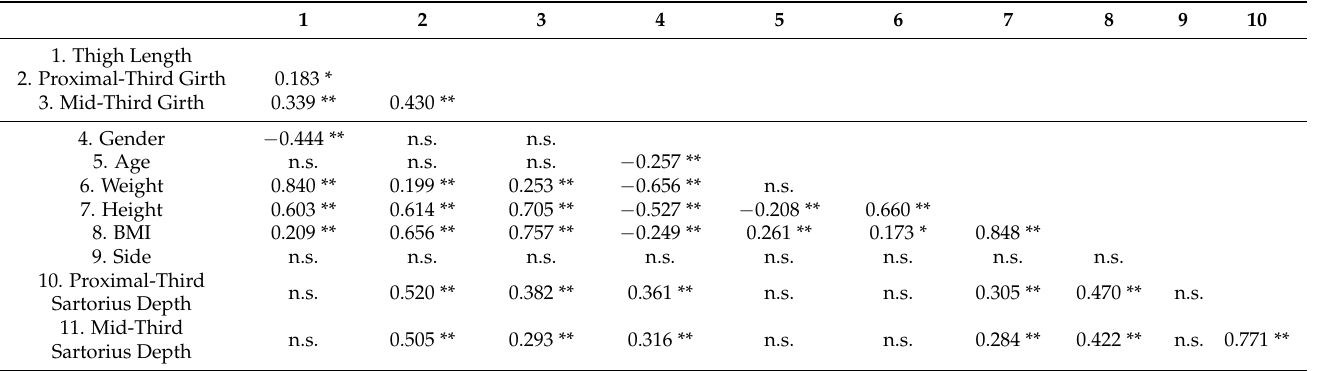
Table 3. Pearson-Product Moment Correlation Matrix.